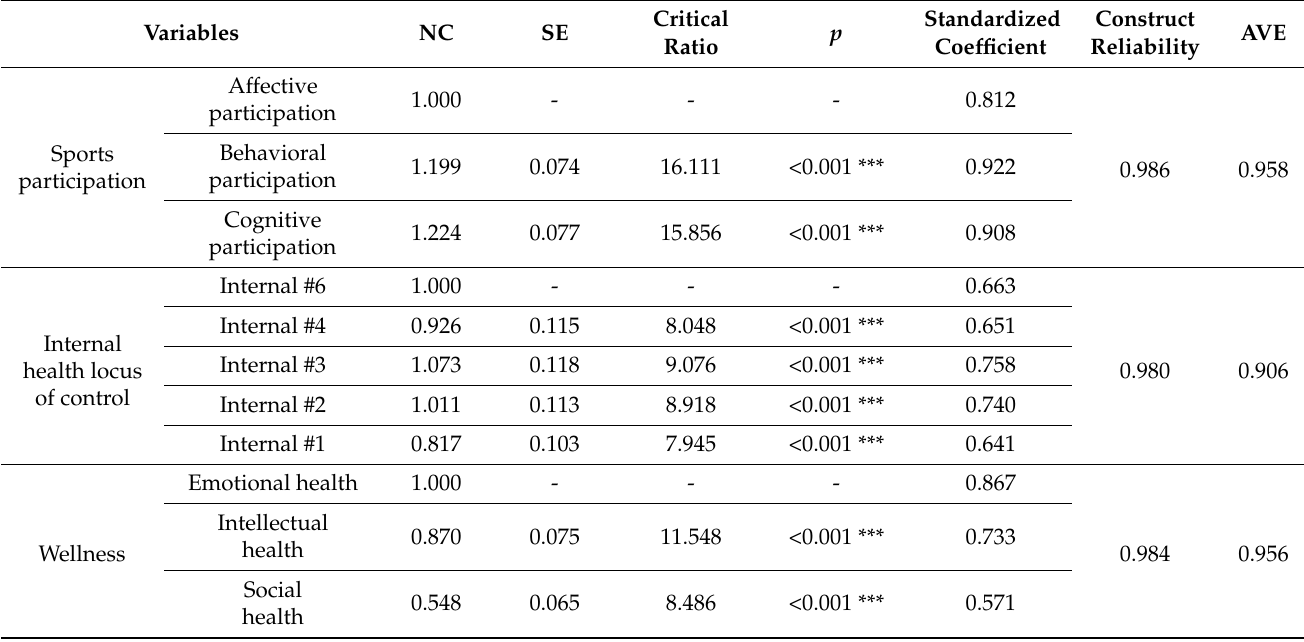
Table 2. Results of the confirmatory factor